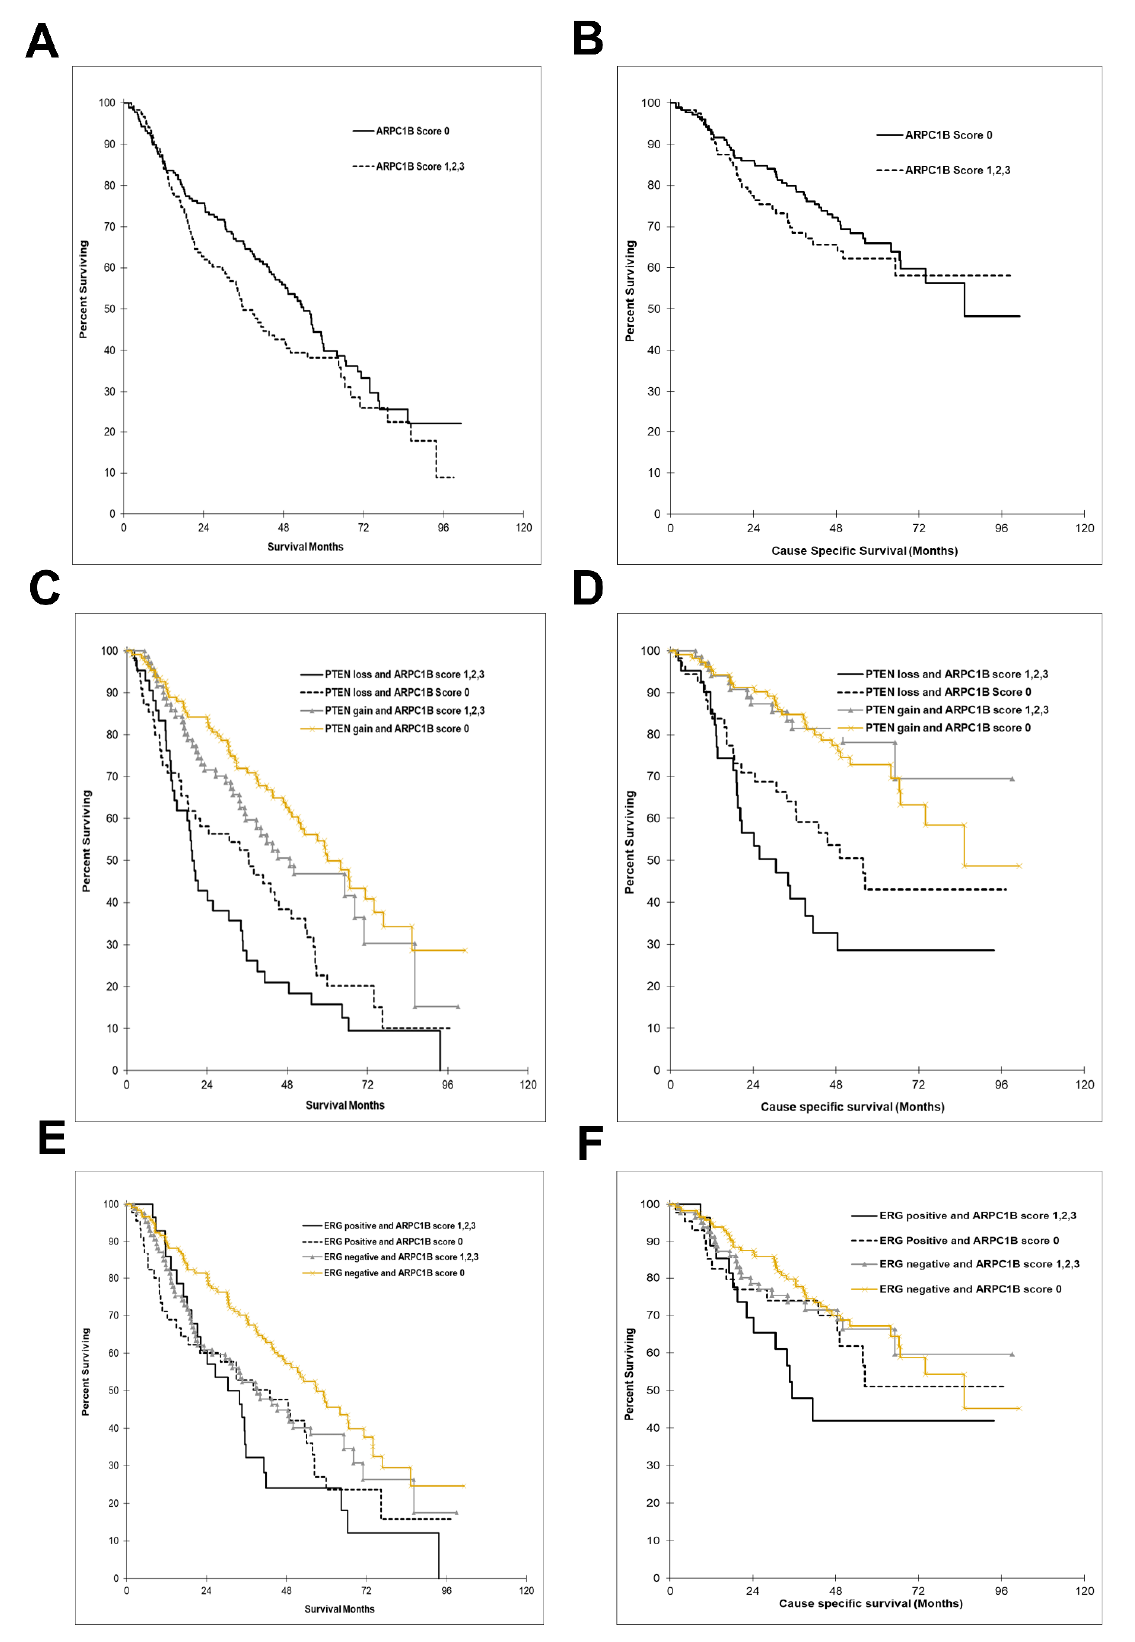
Figure 2. Kaplan–Meier (KM) curves demonstrating ARPC1B expression in relation to prostate cancer cases overall survival and cause-specific survival. ( A ) overall survival according to